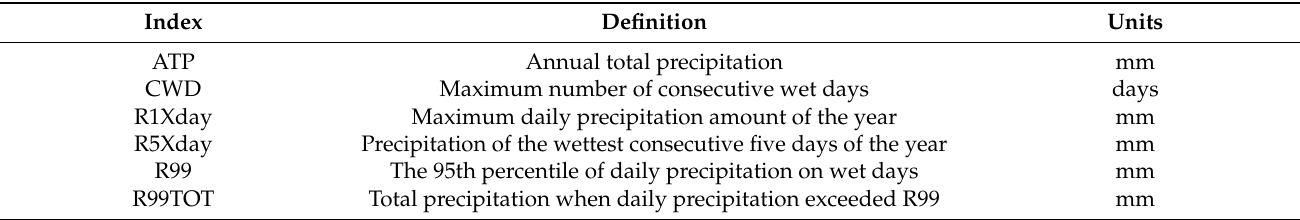
Table 1. Detailed information on precipitation